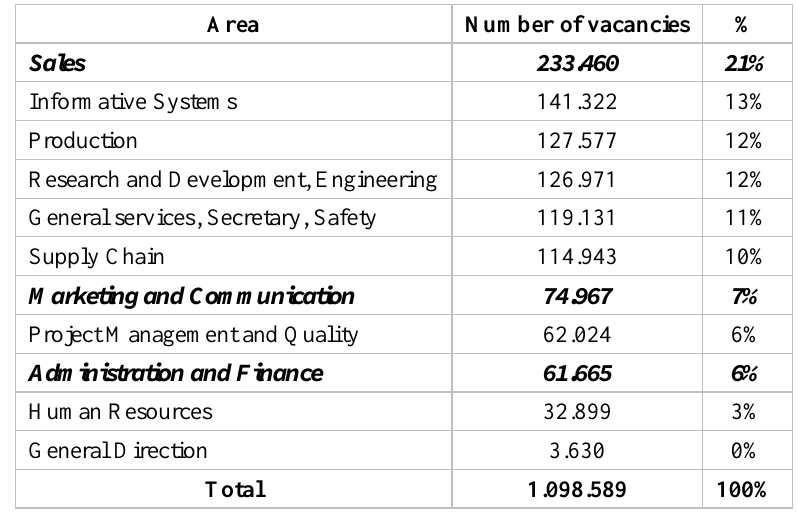
Table 1: Number of Vacancies by